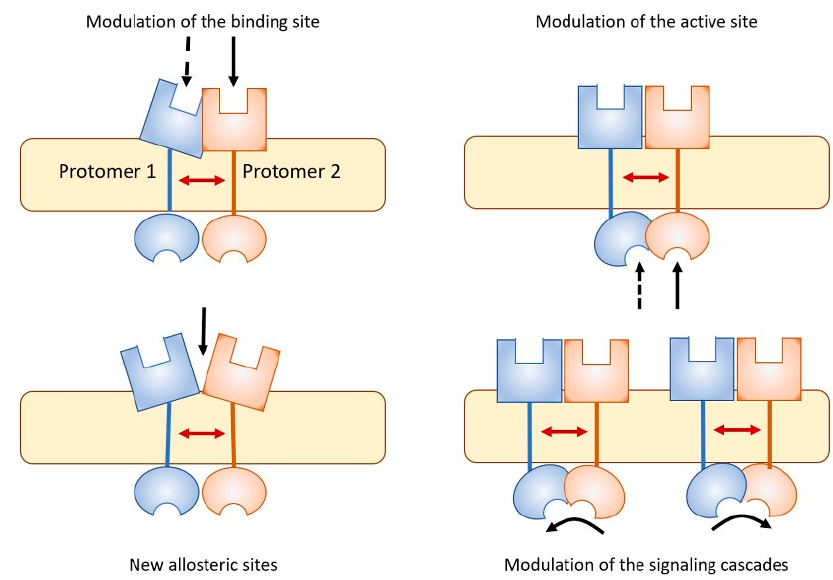
Figure 3. As a result of allosteric RRI, receptor complexes appear to be endowed with pharmacological features that cannot be fully derived from the characteristics of the single participating protomers (see [140] for a review). Some examples are illustrated. Complex formation can lead to modulation of the binding sites, modulation of intracellular active sites, generation on the complex of novel sites suitable for the binding of allosteric modulators, and modulation of the signaling cascade, as for instance the switch from G protein to β -arrestin signaling in GPCRs.